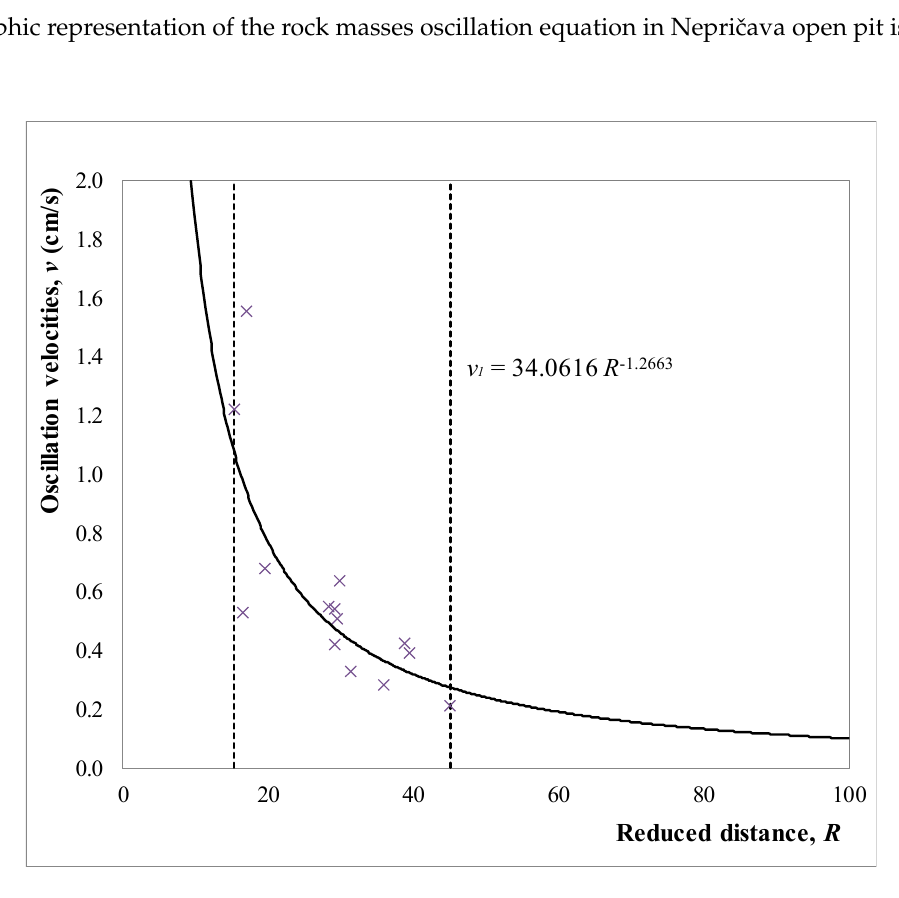
Figure 4. Graphic representation of rock masses oscillation velocity in Nepri č ava open pit.